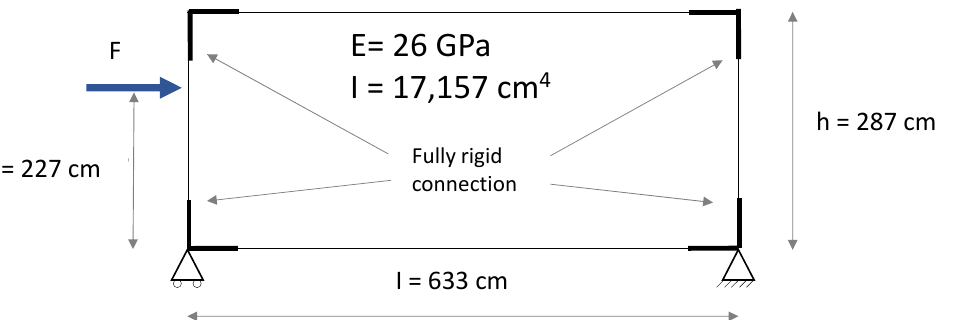
Figure 16. Structural scheme adopted in the numerical model of the GFRP portal frame.